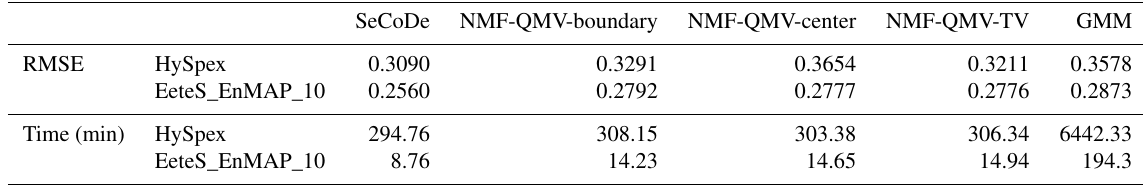
Table 4. Quantitative assessment of unmixing algorithms for the sub1 region.